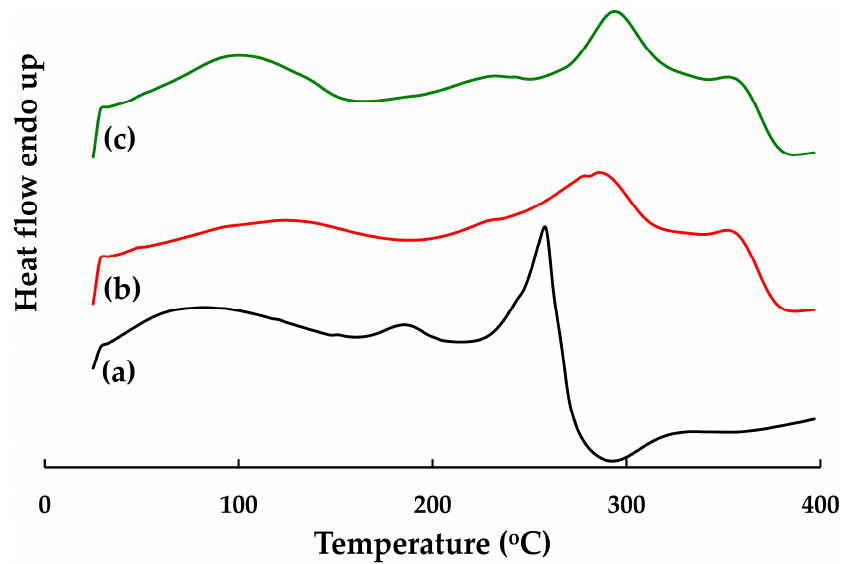
Figure 10. DSC thermograms of (a) silver-nanoparticle-complexed G. applanatum , (b) blank film, and (c) topical film containing silver-nanoparticle-complexed G. applanatum . TGA